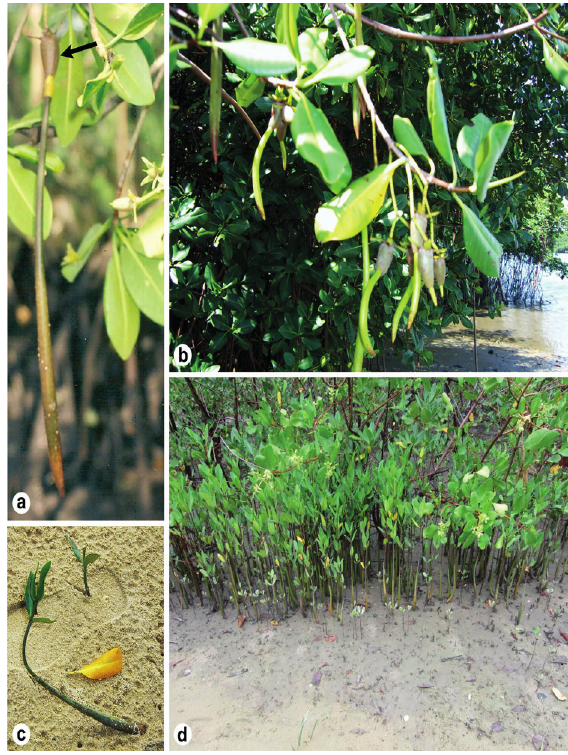
Figure 2 - (a-d): Rhizophora mangle at Porto de galinhas. a - Mature propagule still attached to the fruit. b - Fruits with developing embryos at different stages. c - plantlet/ resulting from a prostrate propagule. d - plantlets one month after rooting by self-